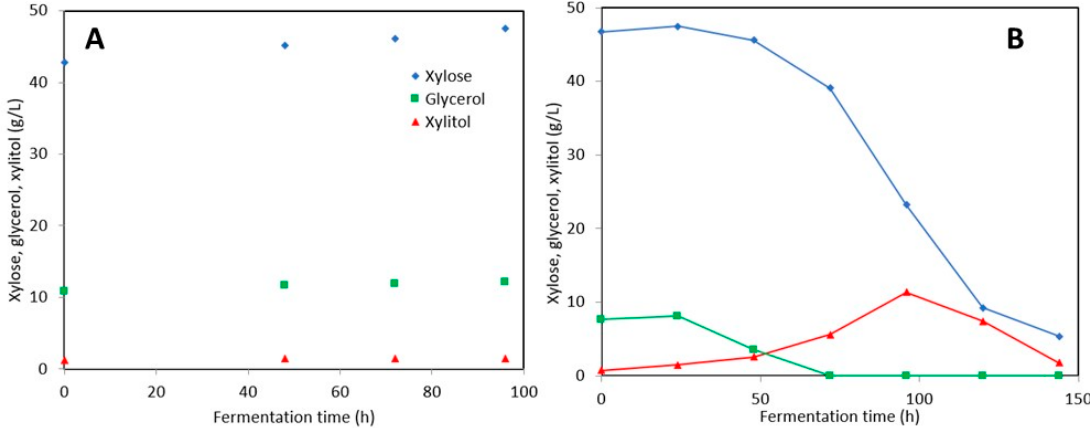
Figure 5. Concentration profiles of xylose ( ♦ ) glycerol ( ■ ) consumption, and xylitol ( ▲ ) generation by C. mogii cultivated in ( A ) non-detoxified stillage media concentrated to one half original volume by water evaporation, and ( B ) non-detoxified stillage media supplemented with xylose to 46.5 g/L. In a separate experiment, xylose and glycerol were added to the original stillage to bring their initial concentrations to the same levels as those in the non-detoxified and concentrated stillage media.